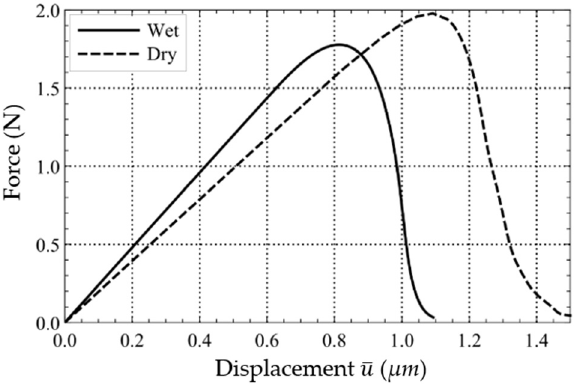
Figure 9. Force-displacement curves of the high-strength concrete specimen in the dry and water- saturated states.